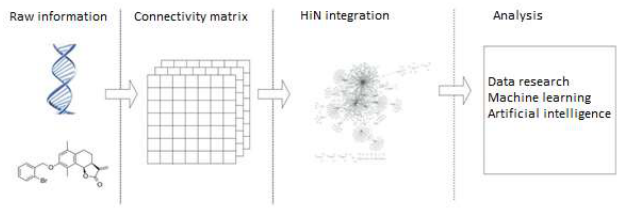
Figure 13. Biological data analysis based on HIN